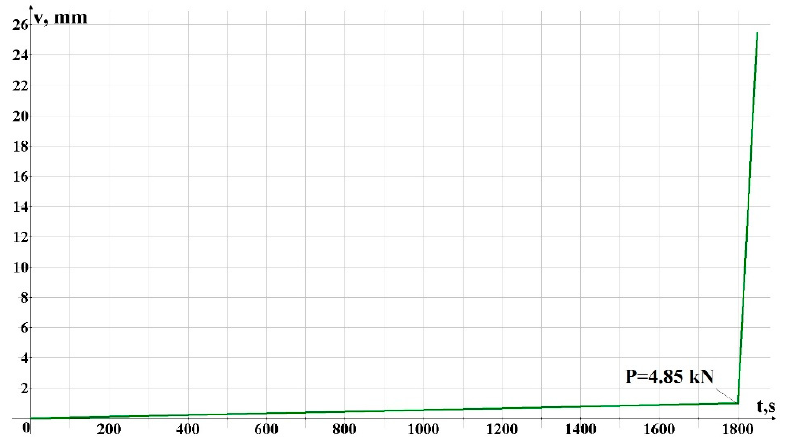
Figure 18. Truss after the destruction of the lower belt. Experiment No. 2.